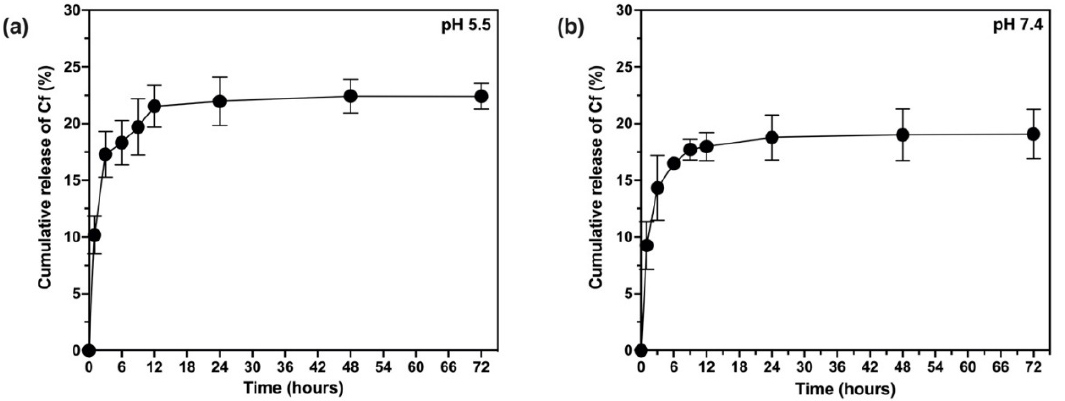
Figure 10. In vitro release profiles of Cf from PLGA NPs in different pH media: pH 5.5 ( a ) and pH 7.4 ( b ).